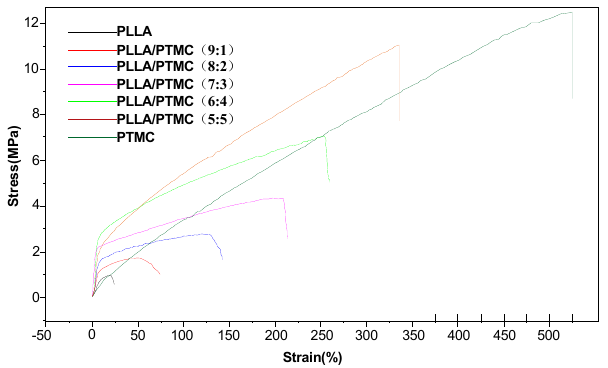
Figure 5. Stress–strain curves of PLLA/PTMC electrospun fibre membrane scaffolds. Table 1. Mechanical properties of PLLAa /PTMCb electrospun fibre membrane scaffolds.